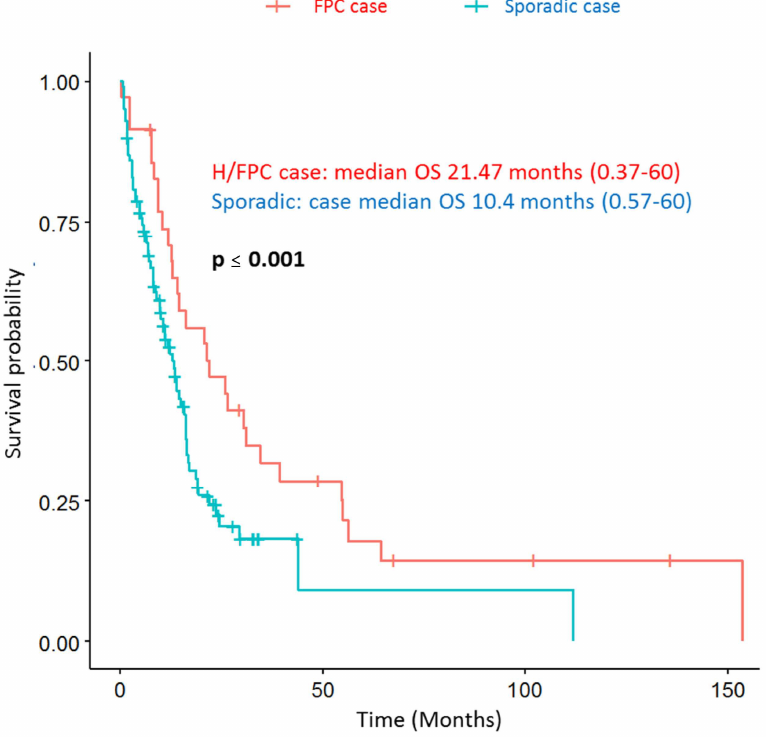
Figure 4. Hereditary or familial PDAC cases have a longer overall survival (OS) compared to sporadic